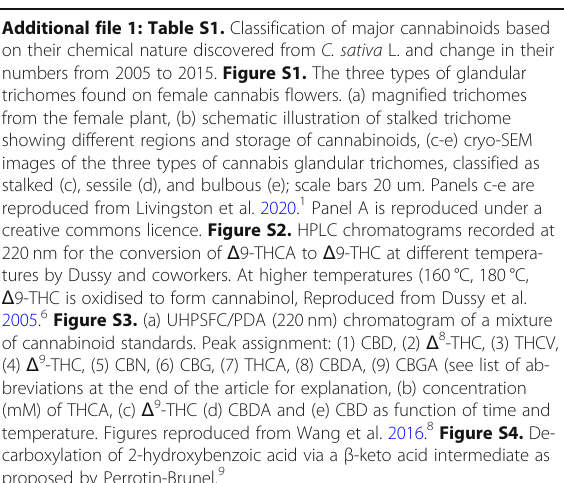
Additional file 1: Table S1. Classification of major cannabinoids based on their chemical nature discovered from C. sativa L. and change in their numbers from 2005 to 2015. Figure S1. The three types of glandular trichomes found on female cannabis flowers. (a) magnified trichomes from the female plant, (b) schematic illustration of stalked trichome showing different regions and storage of cannabinoids, (c-e) cryo-SEM images of the three types of cannabis glandular trichomes, classified as stalked (c), sessile (d), and bulbous (e); scale bars 20 um. Panels c-e